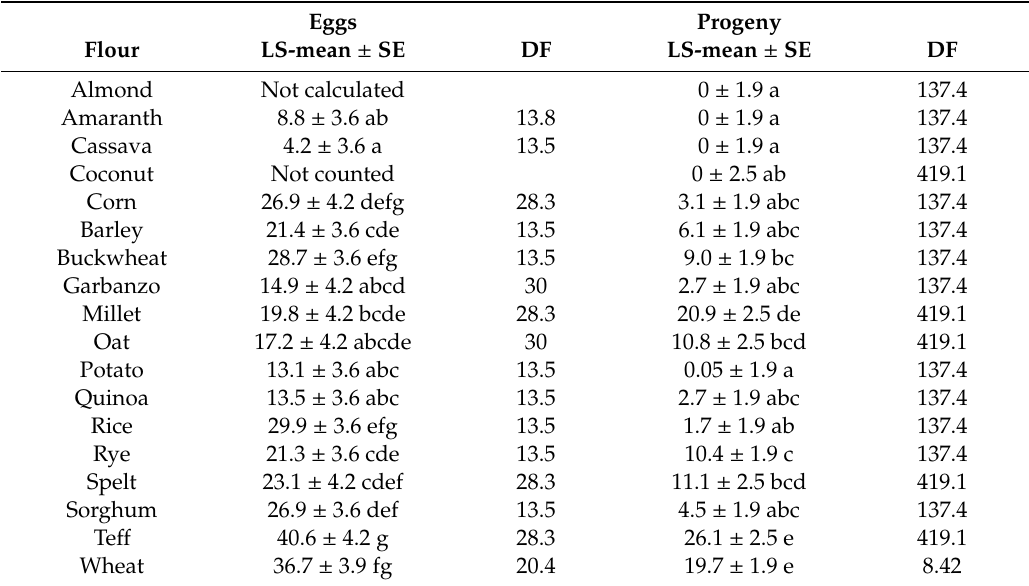
Table 3. Egg and progeny count di ff erences between all flours with no source. Letters represent Tukey adjusted significance at α < 0.05 and are unique to either eggs or progeny